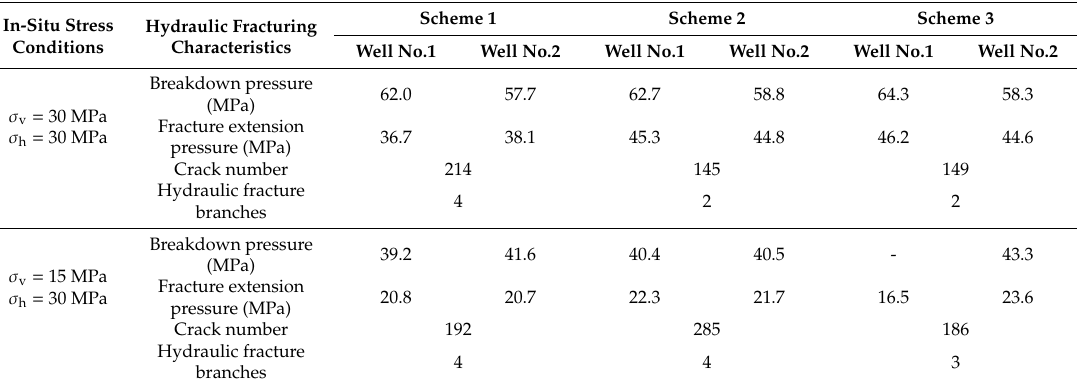
Table 3. Summary of the Fracturing Characteristics for the Two-Well Granite Model with the Well Spacing of 0.5 m under Di ff erent Injection